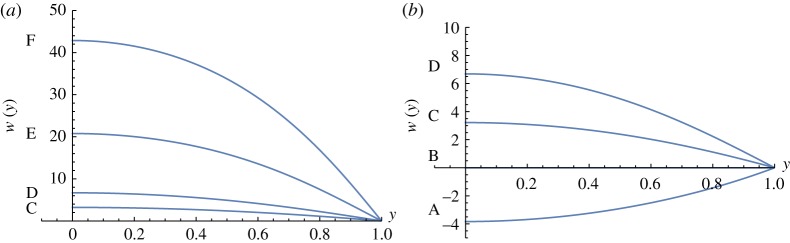
Velocities when ε = 0.01 and r = 0.1.